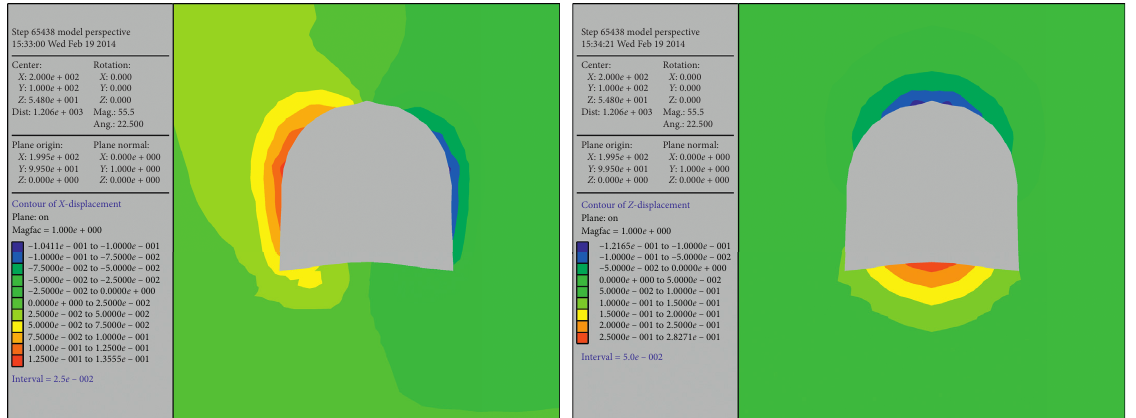
Figure 13: The nephograms of displacement (Scheme